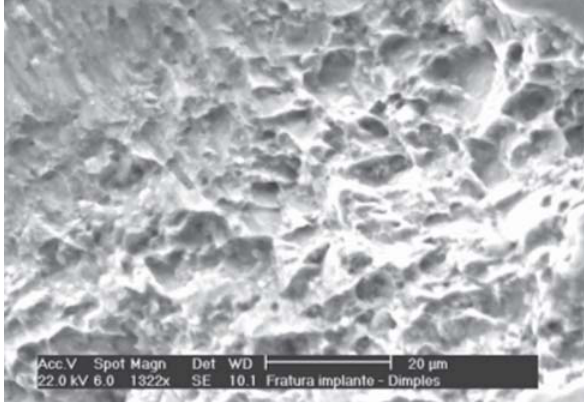
FIGURE 5 - Fractured surface of the second screw with “dimples”, with alveolar-like appearance, which characterizes final fracture at a single time due to